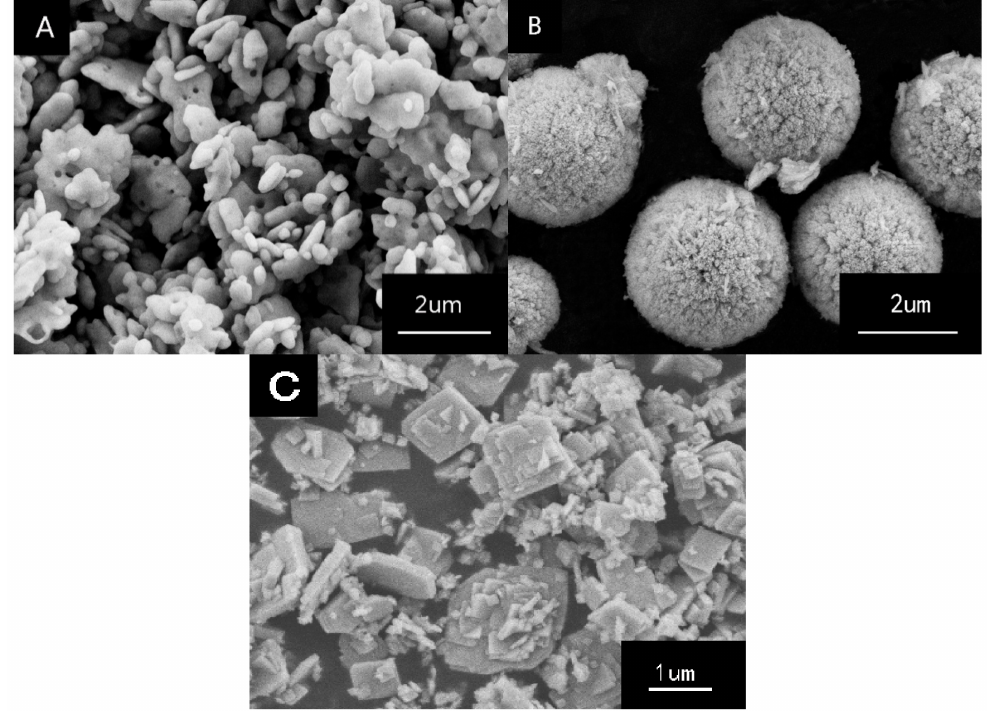
Figure 1. Scanning electron microscopy (SEM) images of barium sulphate (BaSO 4 ): ( A ) in the presence of BaCl 2 and Na 2 SO 4 , ( B ) in the presence of BaCl 2 , Na 2 SO 4 and ethylenediaminetetraacetic acid (EDTA), and ( C ) in the presence of BaCl 2 and Na 2 S 2 O 8 .